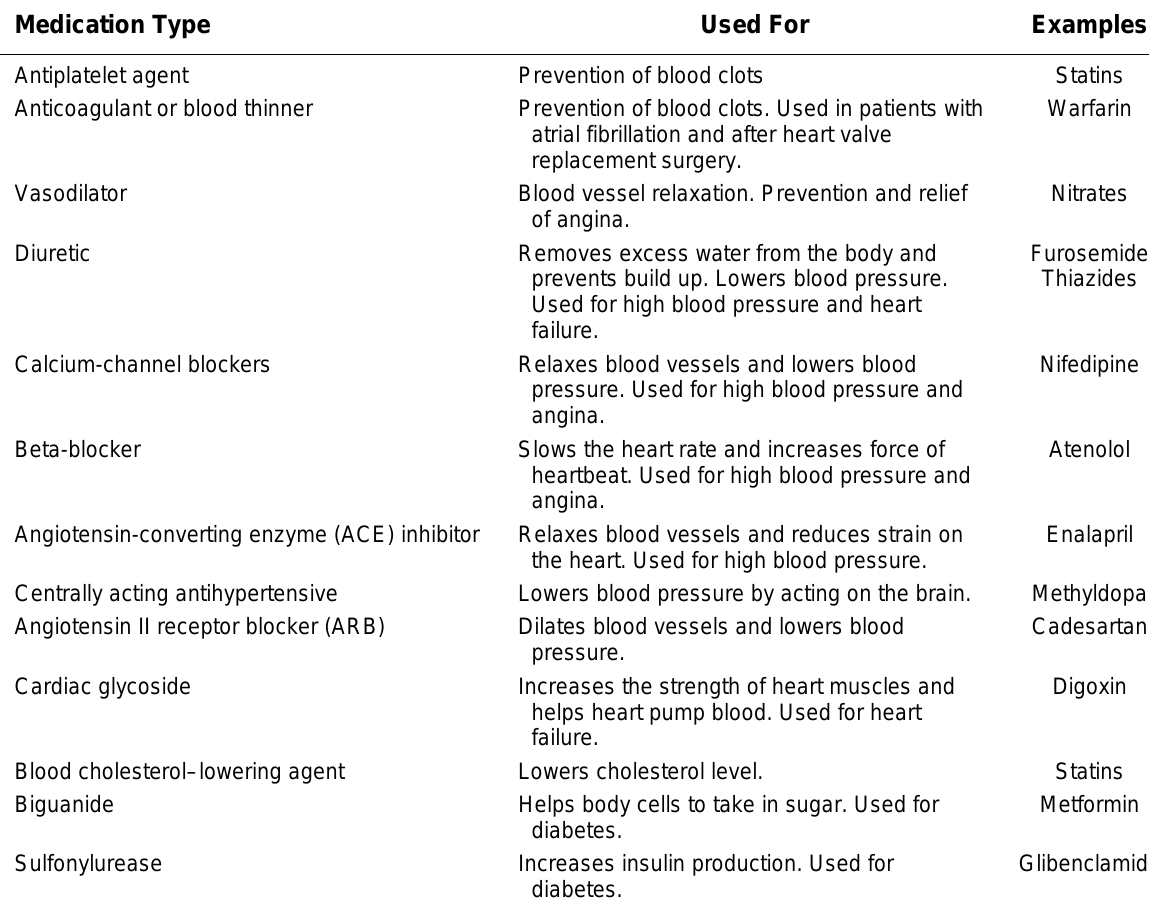
Medication for the Treatment and Management of Cardiovascular Disease (Adapted from World Health Organisation) Medication Type Used For Examples Prevention of blood clots